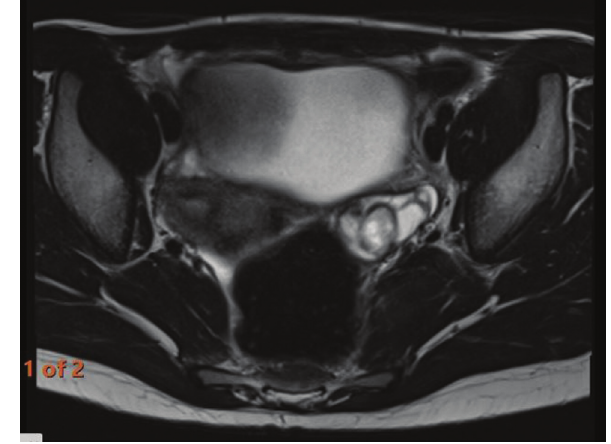
Fig. 3 Magnetic resonance imaging (MRI) demonstrating an axial view of the metachronous left ovarian teratoma